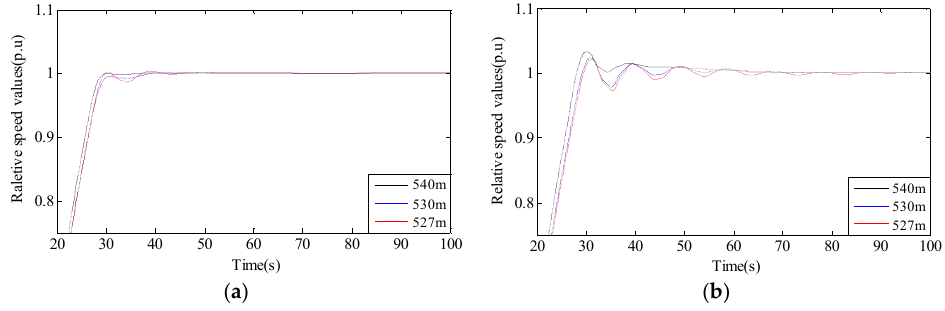
Figure 16. The rotational speed of different controller for various water head under start-up conditions: ( a ) AFPID; ( b ) PID.